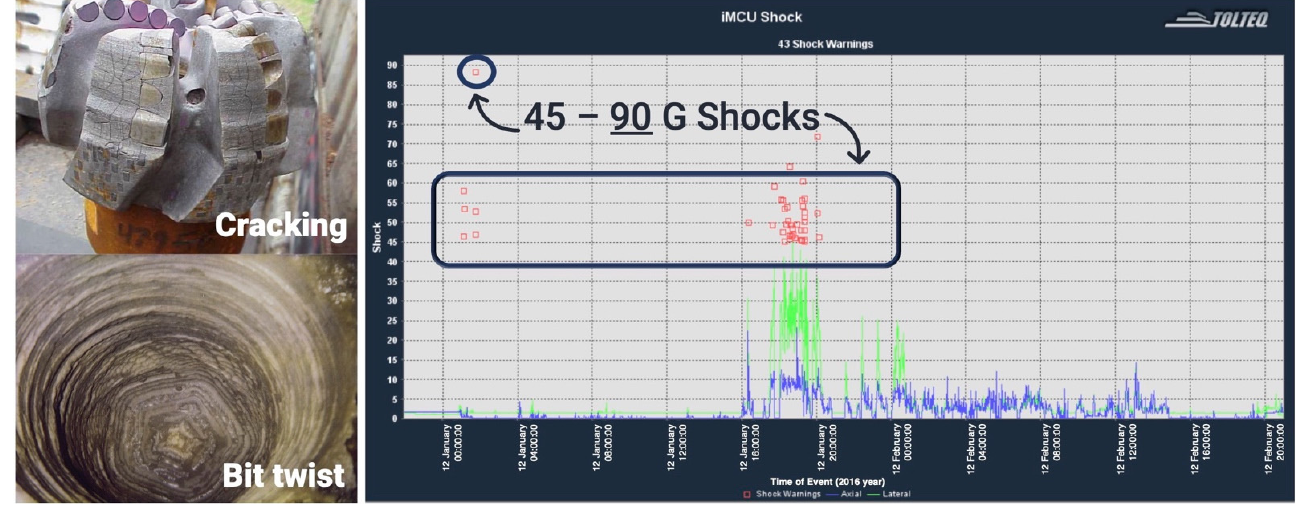
Figure 1. The negative effect of excessive vibration on the PDC bit.